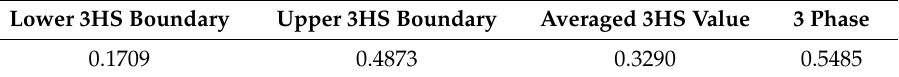
Table 16. Three-phase thermal conductivity approximations—cement system F.